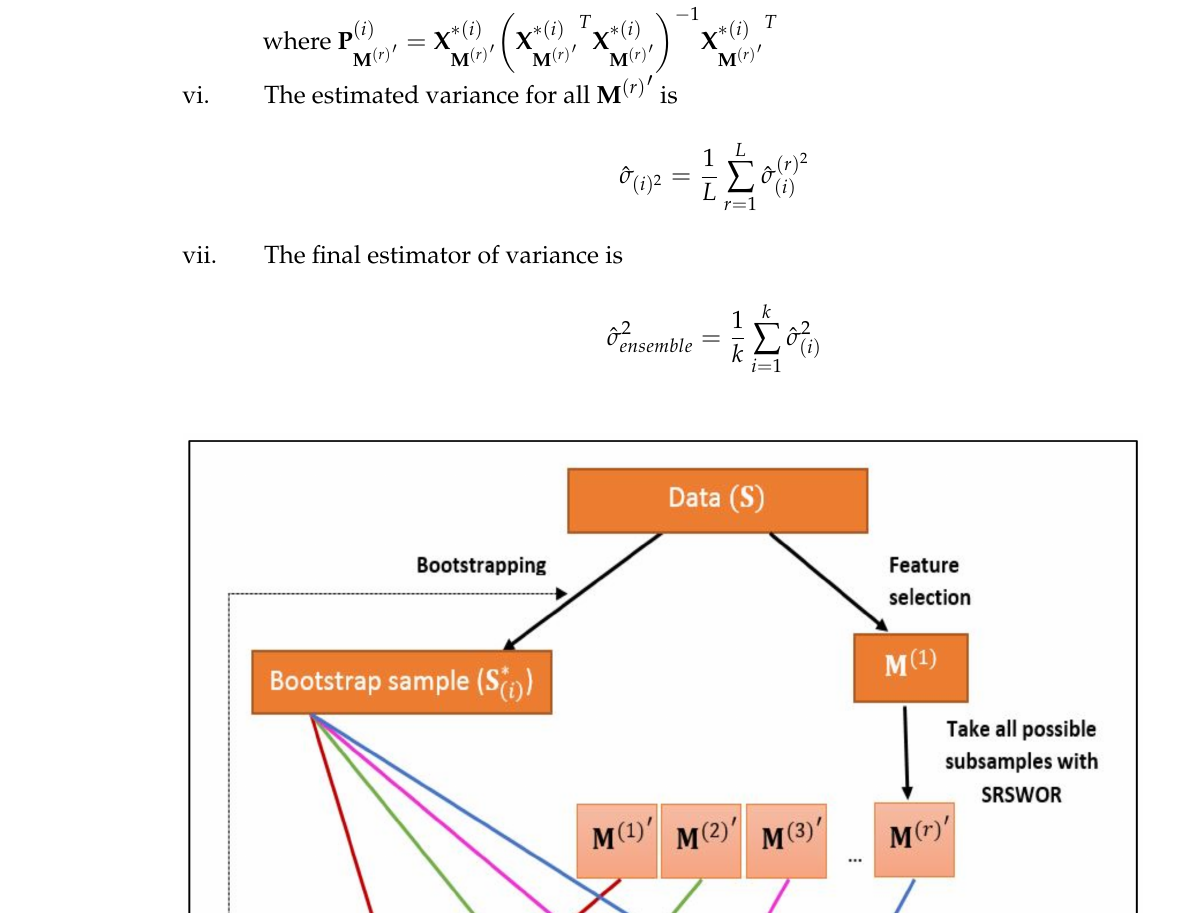
, ˆ σ 2 and ˆ σ 2 , respectively. Sp LASSO LSR represents σ 2 , ˆ σ 2 and ˆ σ 2 . This means all the Sp LASSO LSR ensemble